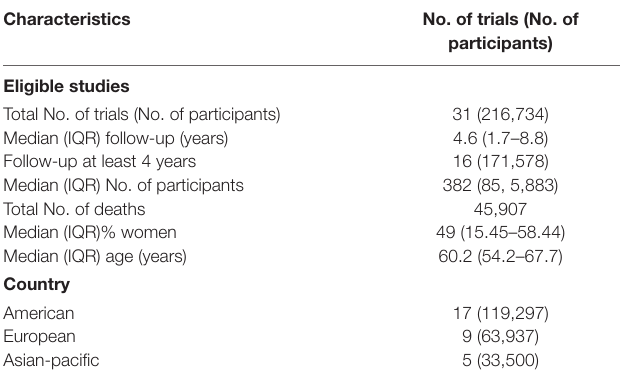
TABLE 1 | Summary characteristics of included studies.